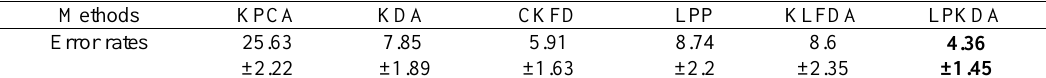
Table 6. The average error rates (%) across 10 tests and their standard deviations (std) on COIL20 database.